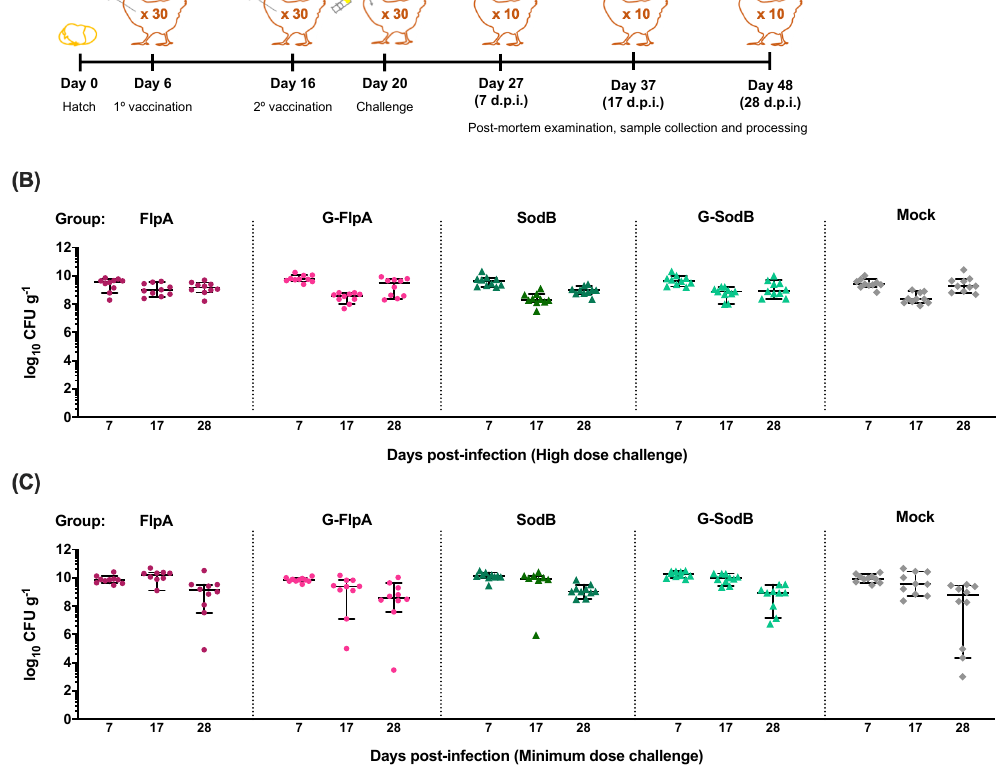
Figure 3. Caecal colonisation by C. jejuni M1 post-vaccination and oral challenge. ( A ) White Leghorn chickens were vaccinated with FlpA ( • ), G-FlpA ( • ), SodB ( (cid:78) ), G-SodB ( (cid:78) ) or PBS (mock-vaccinated, (cid:7) ) mixed with adjuvant at days 6 and 16 of life followed by oral challenge with C. jejuni M1 at day 20 of life. Post-mortem examinations were conducted at days 7, 17 and 28 post-infection to study caecal colonisation levels of C. jejuni M1 and immune responses. ( B ) Following a high dose challenge of 10 7 CFU of C. jejuni M1, high caecal loads were observed in all groups that were not significantly di ff erent between vaccinated and mock-vaccinated groups. ( C ) Similar results were observed in a minimum dose challenge trial in which chickens were challenged with 10 2 CFU of C. jejuni M1, further demonstrating that the challenge dose did not a ff ect the outcome of